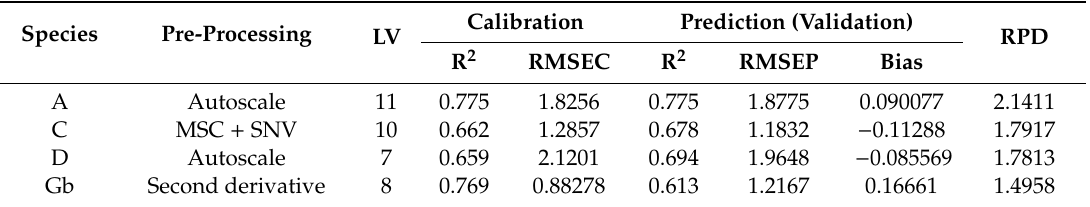
Table 7. Best results of species with second derivative data and their preprocessing at a spectral sampling range of 729–975 nm using PLSR.